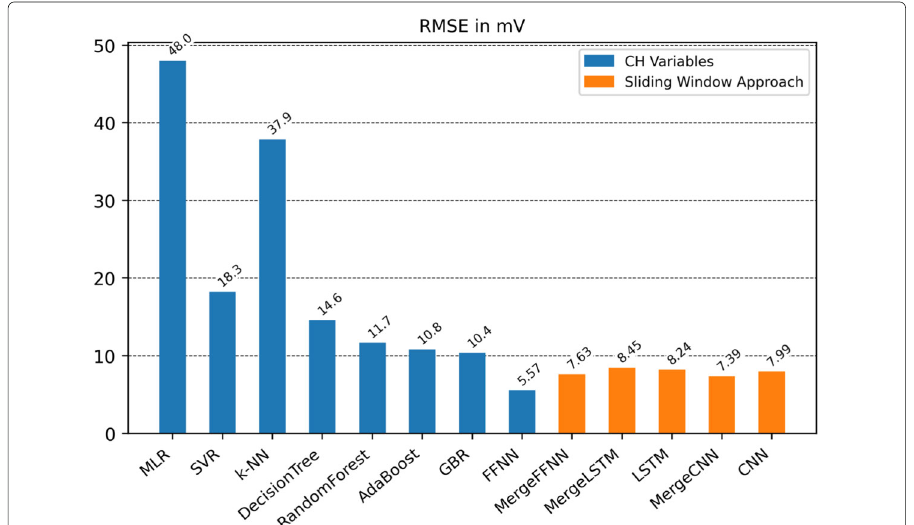
Fig. 6 RMSE of the different ML methods using CH variables (blue) or sliding window approach